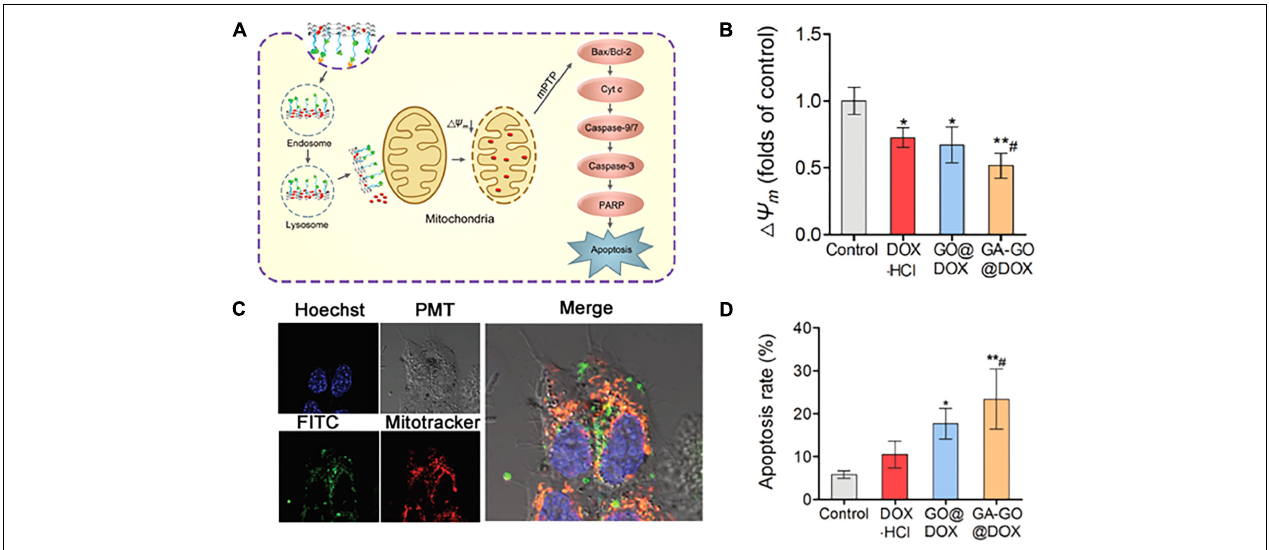
FIGURE 7 | (A) Schematic illustration of the proposed mechanism of the MMA pathway of GA-GO@DOX. (B) (cid:49)(cid:57) m of HepG2 cells after incubation with DOX · HCl, GO@DOX, GA-GO@DOX, and the control at an equivalent DOX dose of 0.5 µ g mL − 1 for 24 h. (C) CLSM images of the intracellular localization of GA-GO-FITC in HepG2 cells after treatment with GA-GO-FITC (800 µ g mL − 1 ) for 6 h. The cells were stained with organelle trackers for 45 min. (D) The apoptosis rate of HepG2 cells after treatment with DOX · HCl, GO@DOX, GA-GO@DOX, and the control. Images were adapted with permission from reference (Zhang et al., 2018). Bars represent means ± SD ( n = 3); ∗ p < 0.05 and ∗∗ p < 0.01, compared to control; # p < 0.05, compared to DOX · HCl.